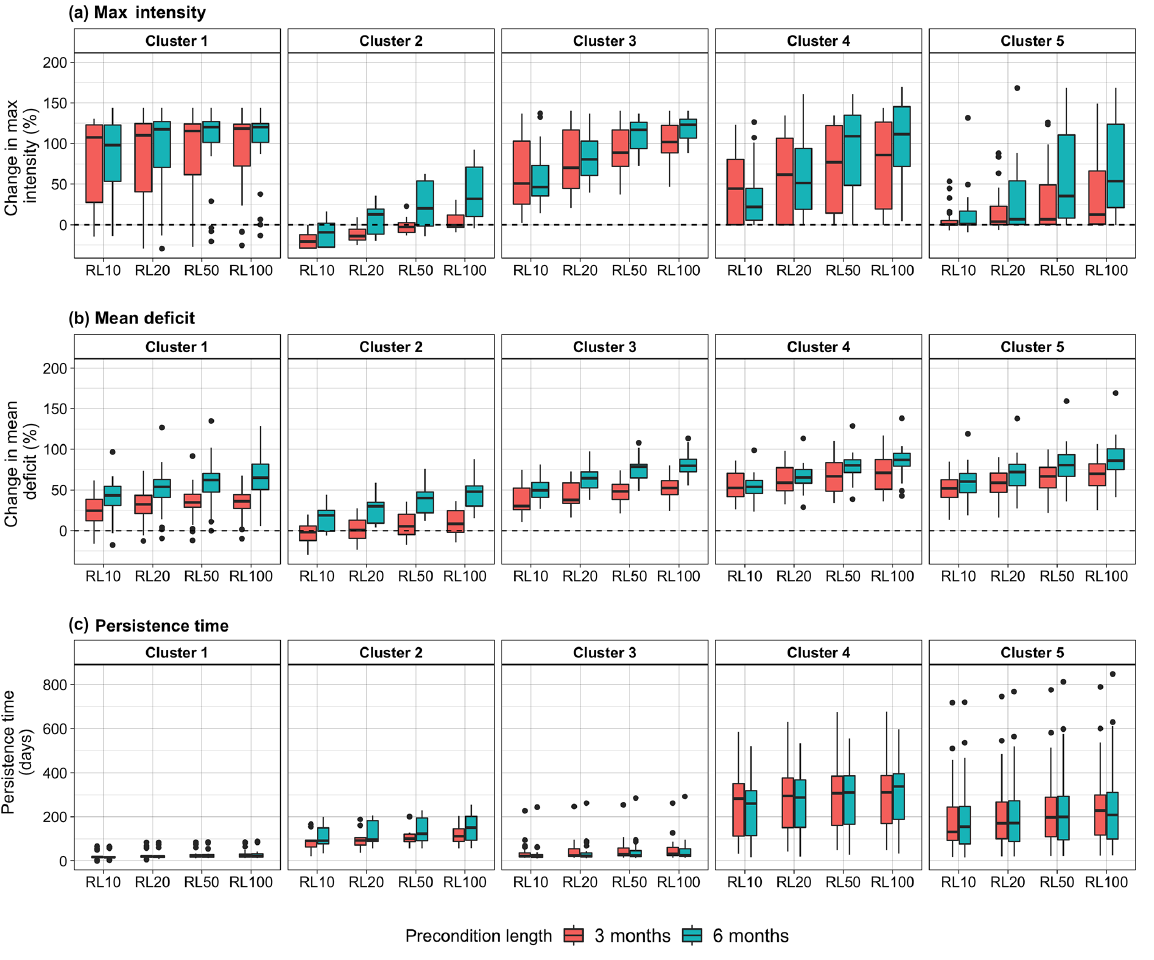
Figure 6. Change in mean drought deficit (%), max drought intensity (%), and persistence time (d) from the storylines of precondition severity at different return levels calculated from